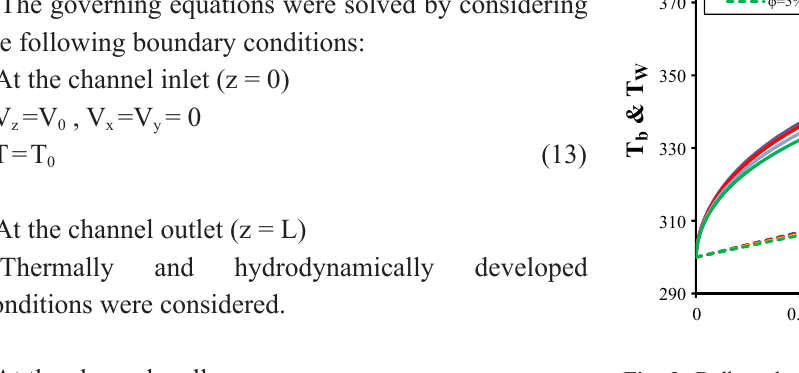
Fig. 3. Bulk and wall temperature vs. axial position for different nanoparticle